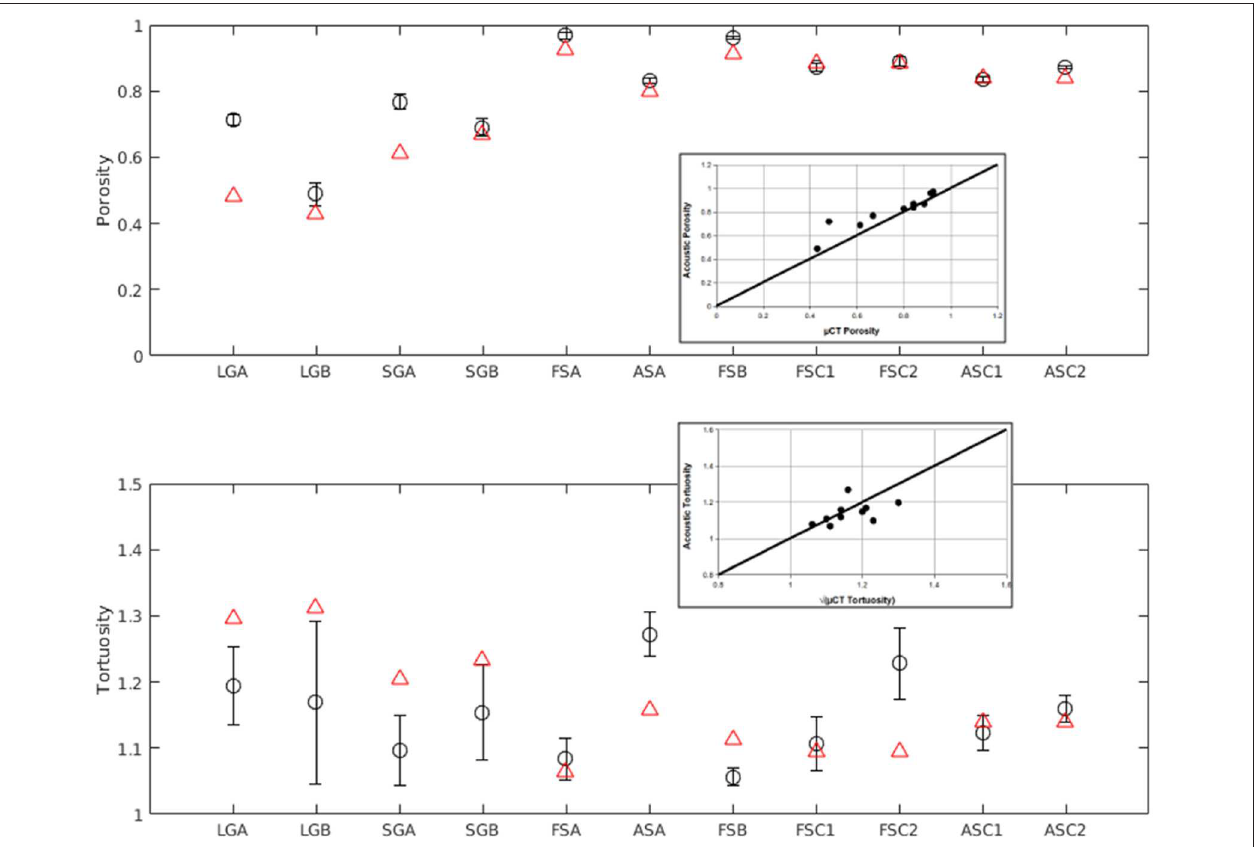
FIGURE 10 | Comparison of porosity and tortuosity values calculated from the acoustic measurements relative to µ CT-measured values. For each graph, acoustic estimates are shown as black circles with the confidence interval indicated for each snow sample. µ CT-measured values are plotted as red triangles. Insets for each graph show a scatter plot of µ CT-measured values vs. acoustically-derived values, along with the 1:1 line.